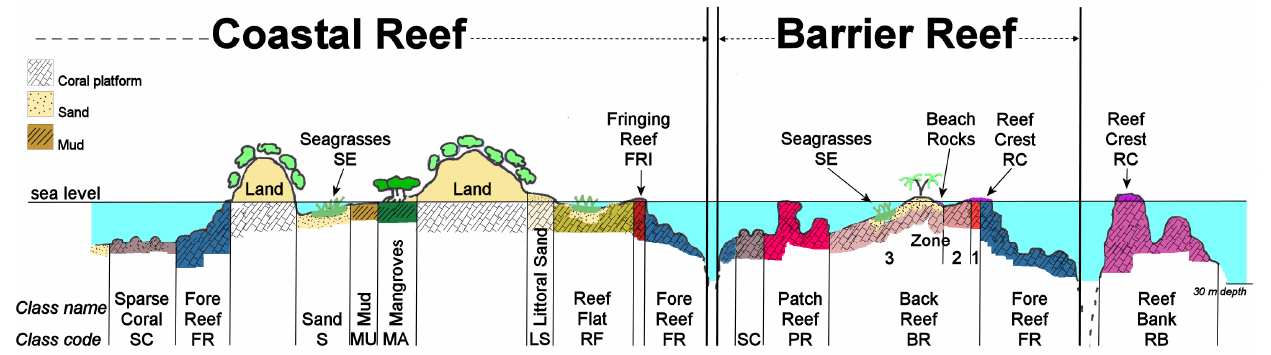
Figure 1. Zonation scheme of the marine shallow-water habitat classes identified and included in the Atlas of the Coastal Marine Habitat of the Kingdom of Tonga. Table 3. Main Classes and subzones used for Tonga habitat mapping. The Ecological Quality Index (EQI) was calculated as the mean of the three-level scores assigned to six ecological parameters (nursery ground, connectivity, species reservoir, fish attraction, biodiversity, primary production).